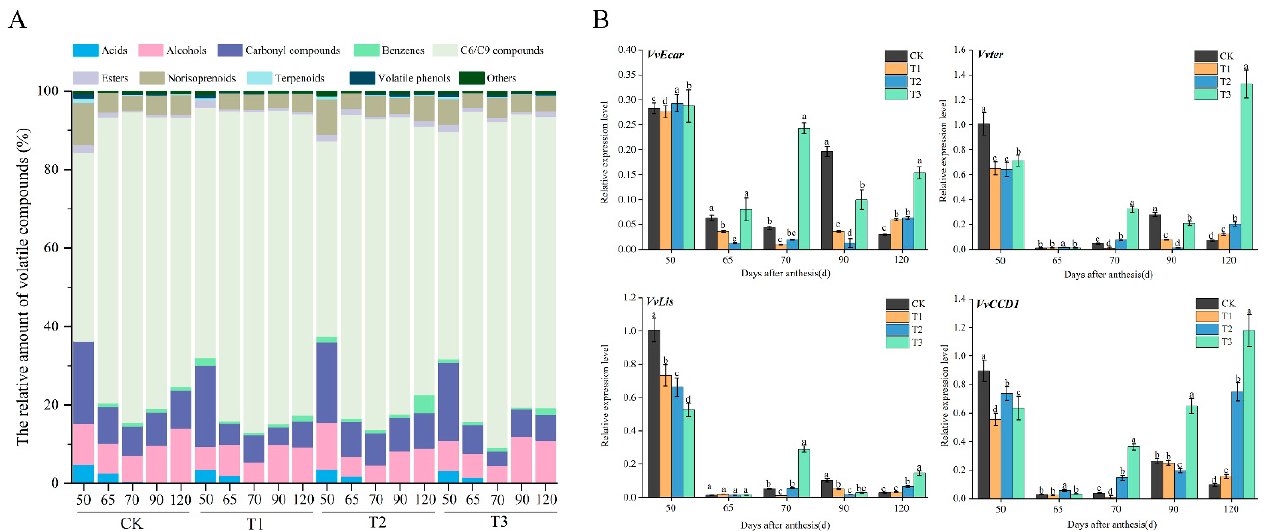
Figure 3. ( A ) Percentage stacked bar chart showing the volatile compounds of the different training system of ‘Cabernet Gernischt’ ( Vitis vinifera L.) during grape maturity. ( B ) Four aromas related genes under the different training system of ‘Cabernet Gernischt’ (Vitis vinifera L.). Different letters denote significant differences separately for individual factors by Tukey’s test at p < 0.05.